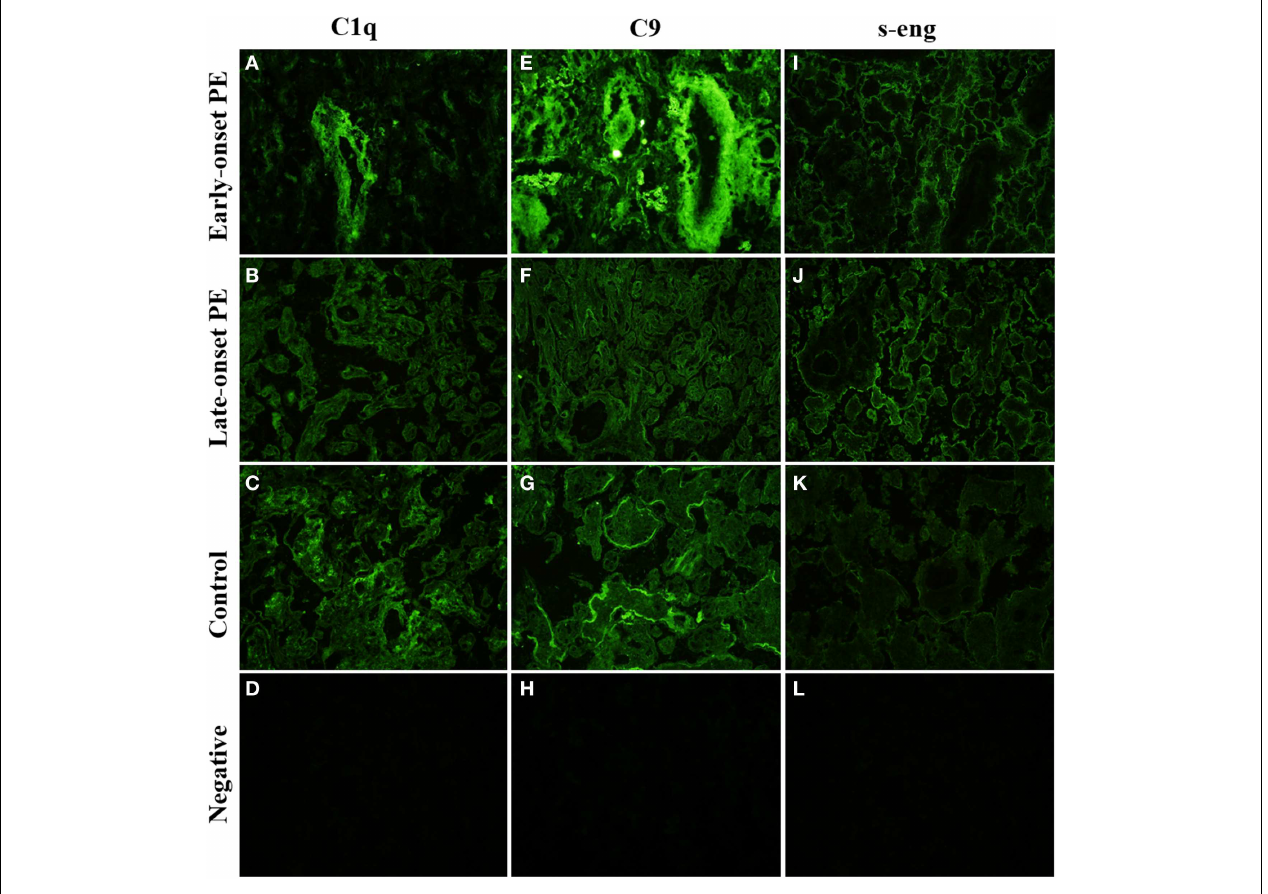
syncytiotrophoblast of PE placentae (I,J) and absent from the control placenta (K) .Top row (A,E,I) : early-onset PE. Middle top row (B,F,J) : late-onset PE. Middle bottom row (C,G,K) : control. Bottom row (D,H,L) : negative control (antibody I omitted). 20 × magnification.